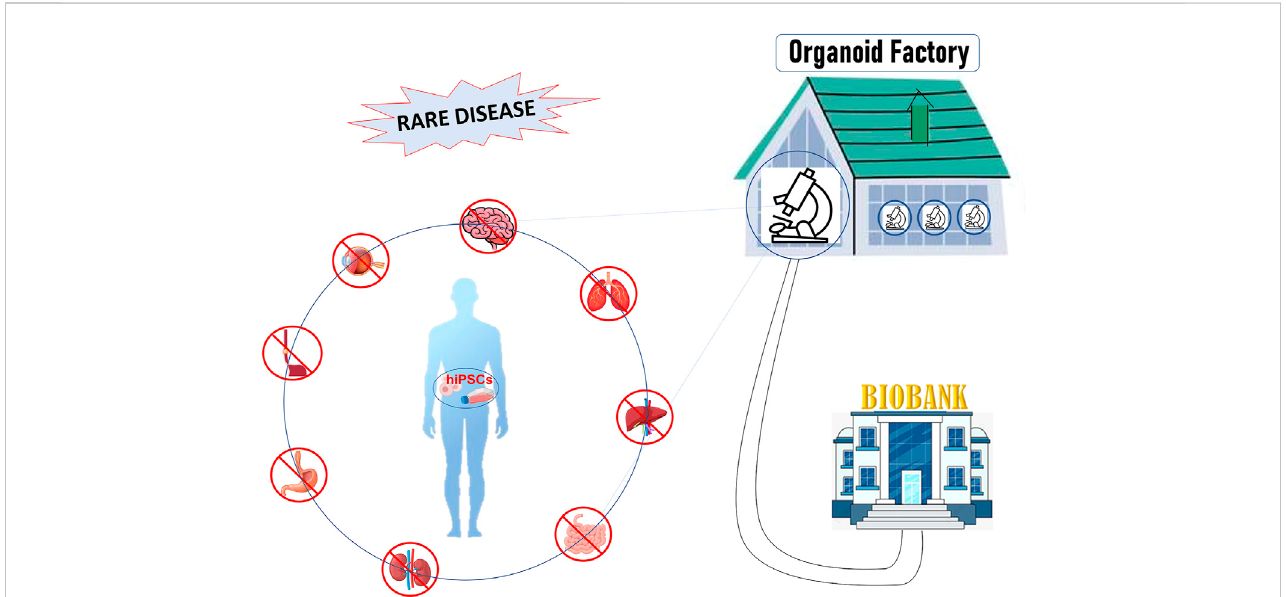
FIGURE 1 Figure 1: hiPSCs offer a unique patient-speci fi c model to study rare disease: hiPSCs can be differentiated into organ-speci fi c cells and assembled into organoidscomprisedoforgan-speci fi ctissue.Organoidsfactoryofferstheuniqueopportunitytocreateplatformsfordrugscreening,regenerativemedicine, toxicity pro fi ling and biobanking, accelerating clinical decision-making process or the discovery of new therapies.